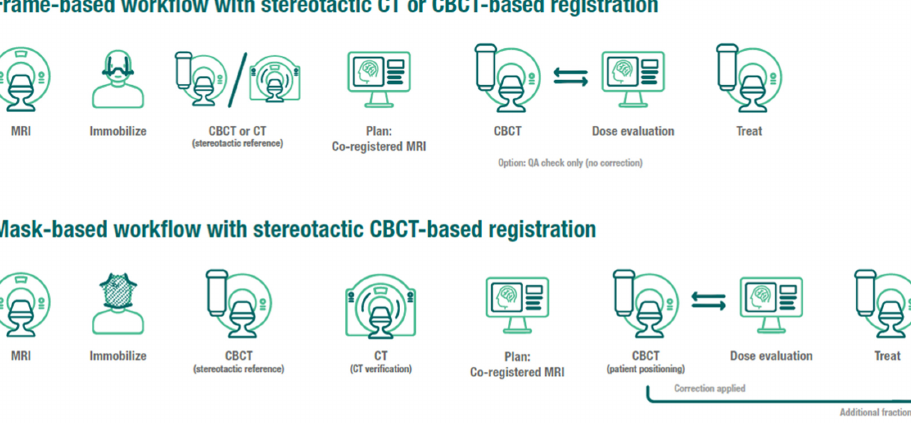
Figure 1. Frame and mask immobilization institutional workflows.